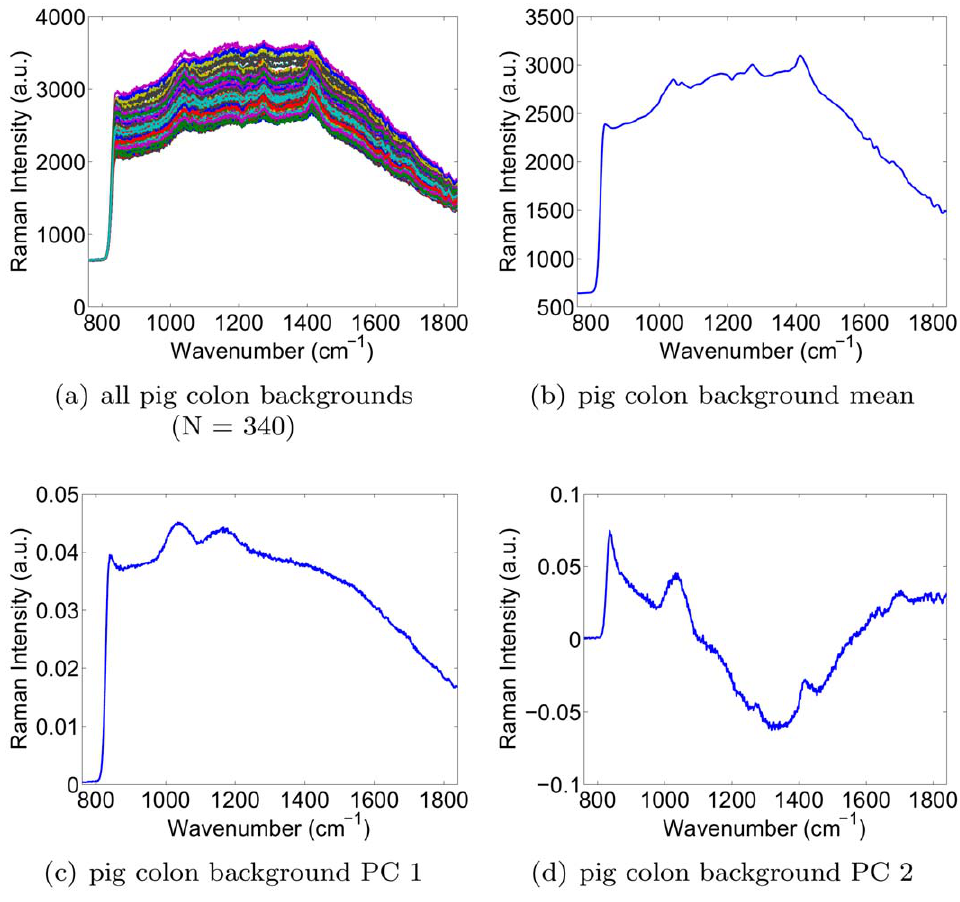
Figure 6. Excised pig colon backgrounds, mean, and first two principal components.